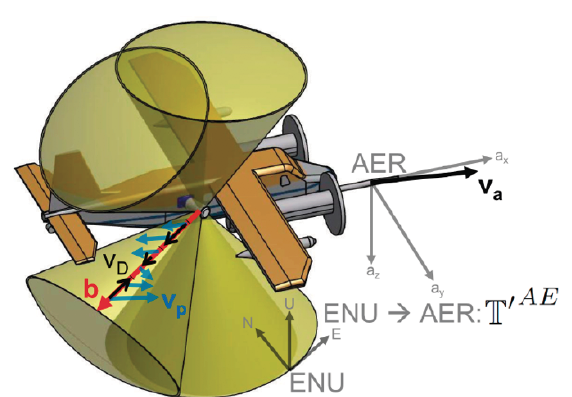
Figure 1: Schematic depiction of the airborne